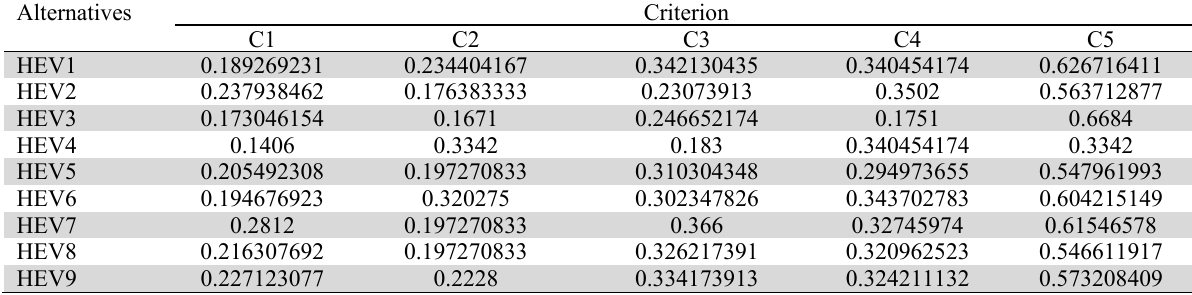
Weighted normalized decision matrix V